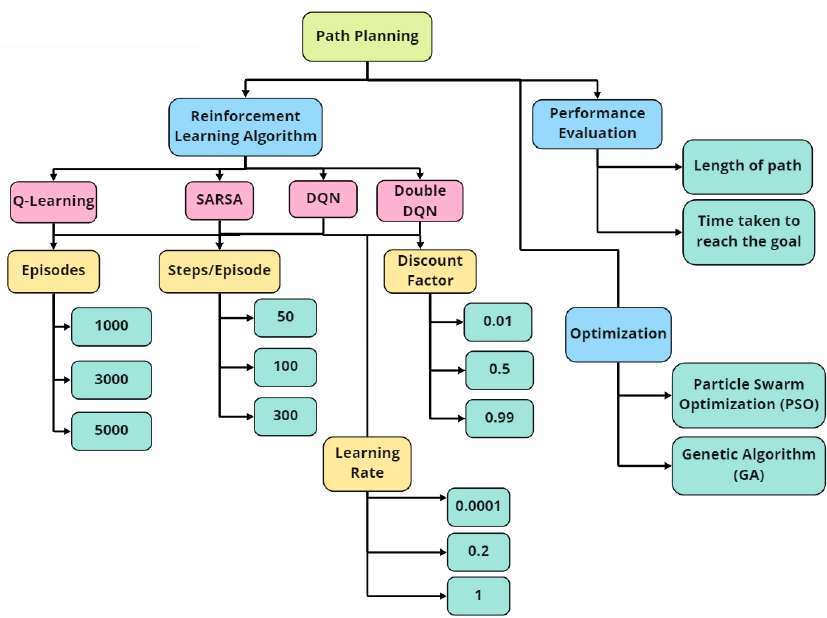
Figure 7. Performance Evaluation of Different Reinforcement Learning Algorithms for Path Planning.